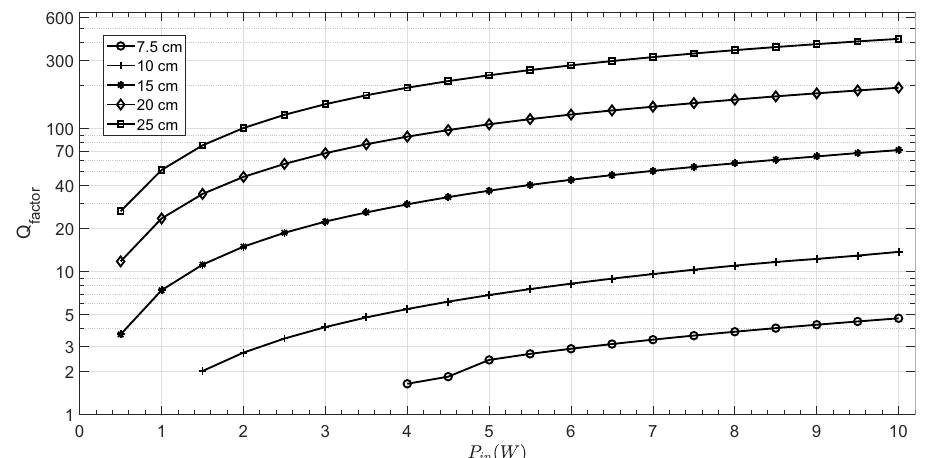
Figure 6: Quality factor ( Q factor ) as a function of the transmitted laser power ( P in ) for a di ff erent telescope diameters ( cm ) W/zero pointing error.